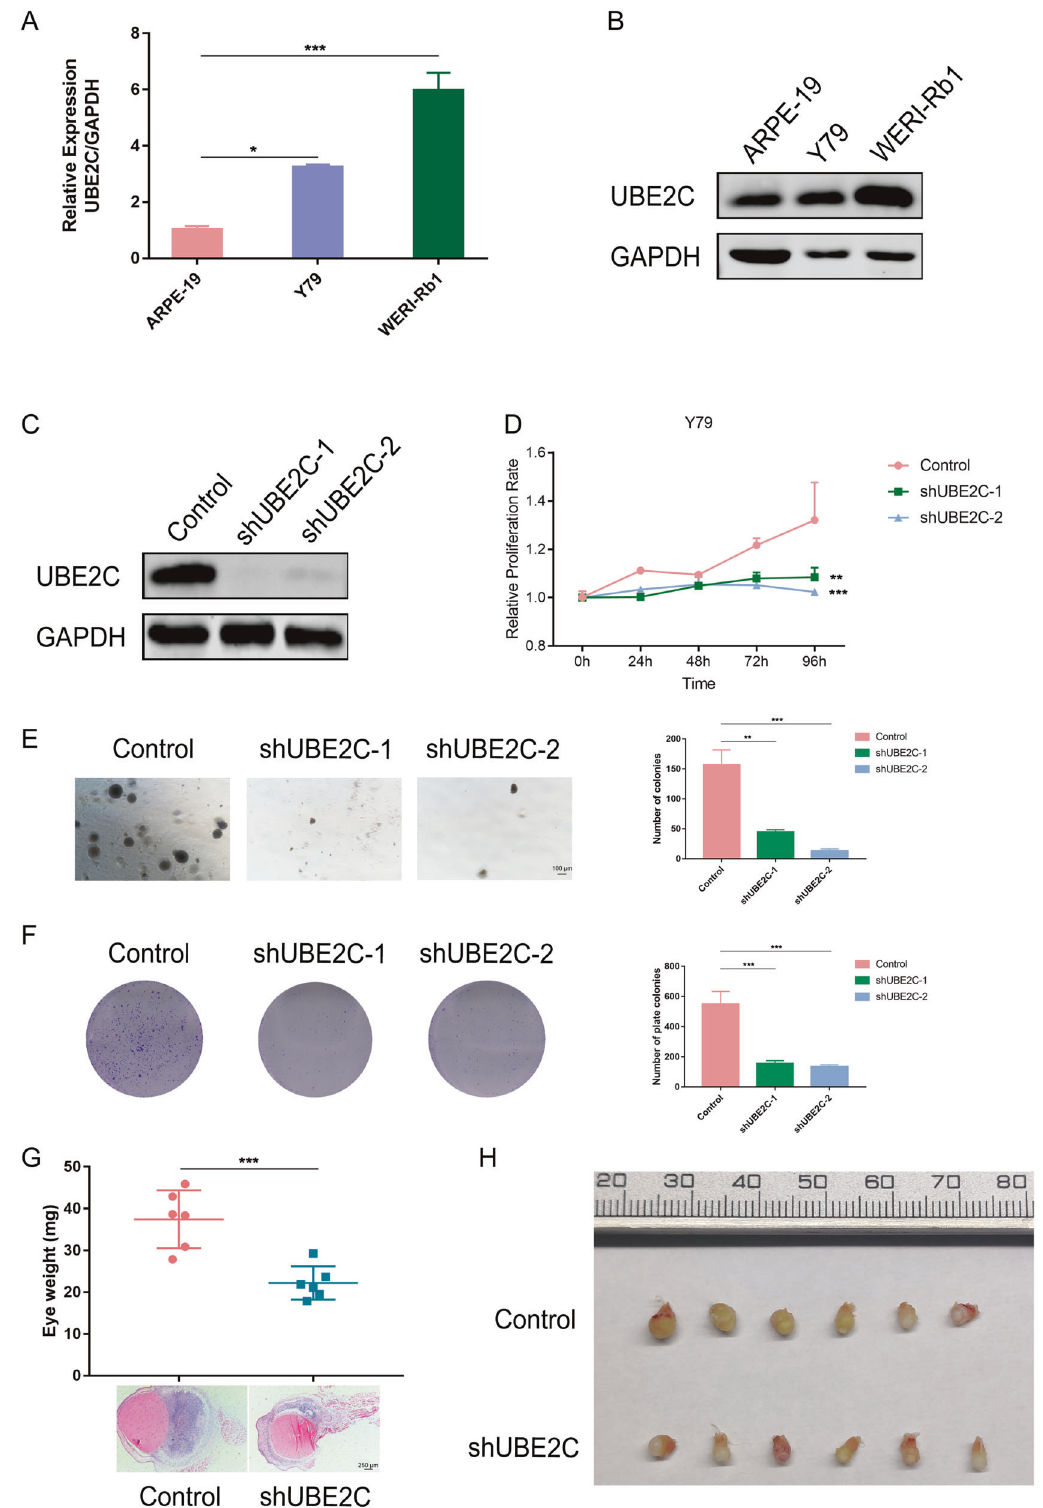
leukocoria and accounts for 3% of pseudo retinoblastomas has rede fi ned as a precancerous lesion characterized by the loss of function of both copies of the RB1 gene, but lacking the additional genomic changes characteristic of retinoblastoma [31]. There is the evidence that retinoma or retinocytoma is a precursor of Cell Death and Disease (2021)